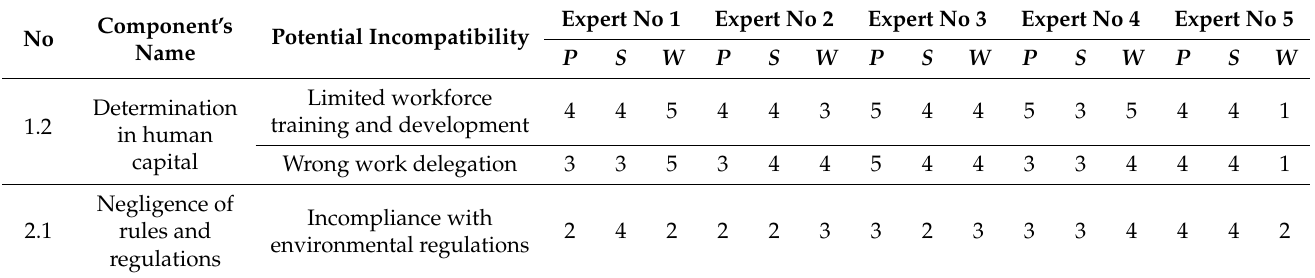
Table 5. Selected assessments of the five experts in a brief form, own